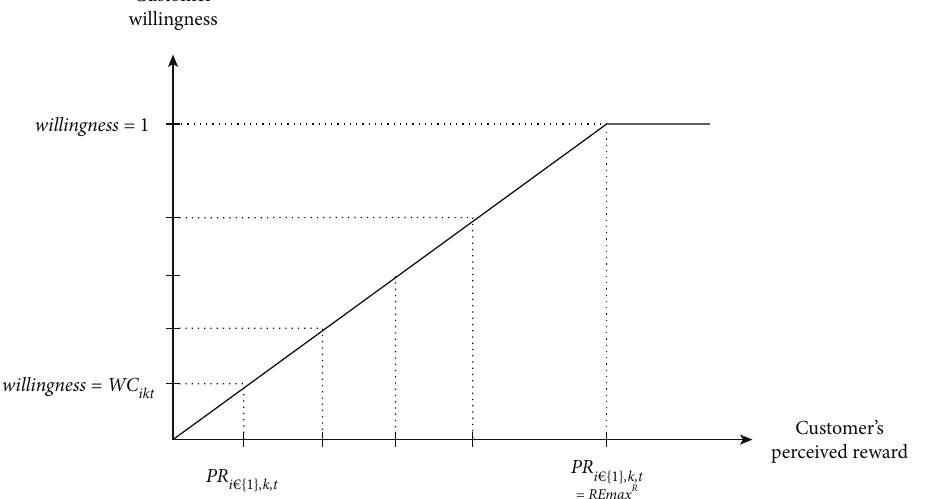
Figure 4: Linear function of the willingness to return according to the change in the customer’s perceived